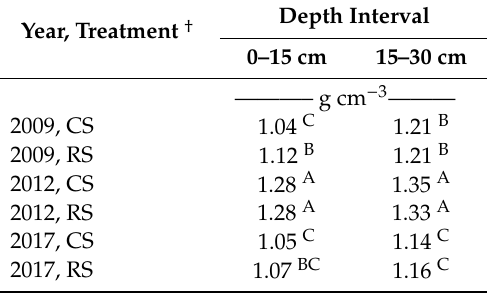
Table A2. Average bulk density for the two soil layers as a function of year × treatment e ff